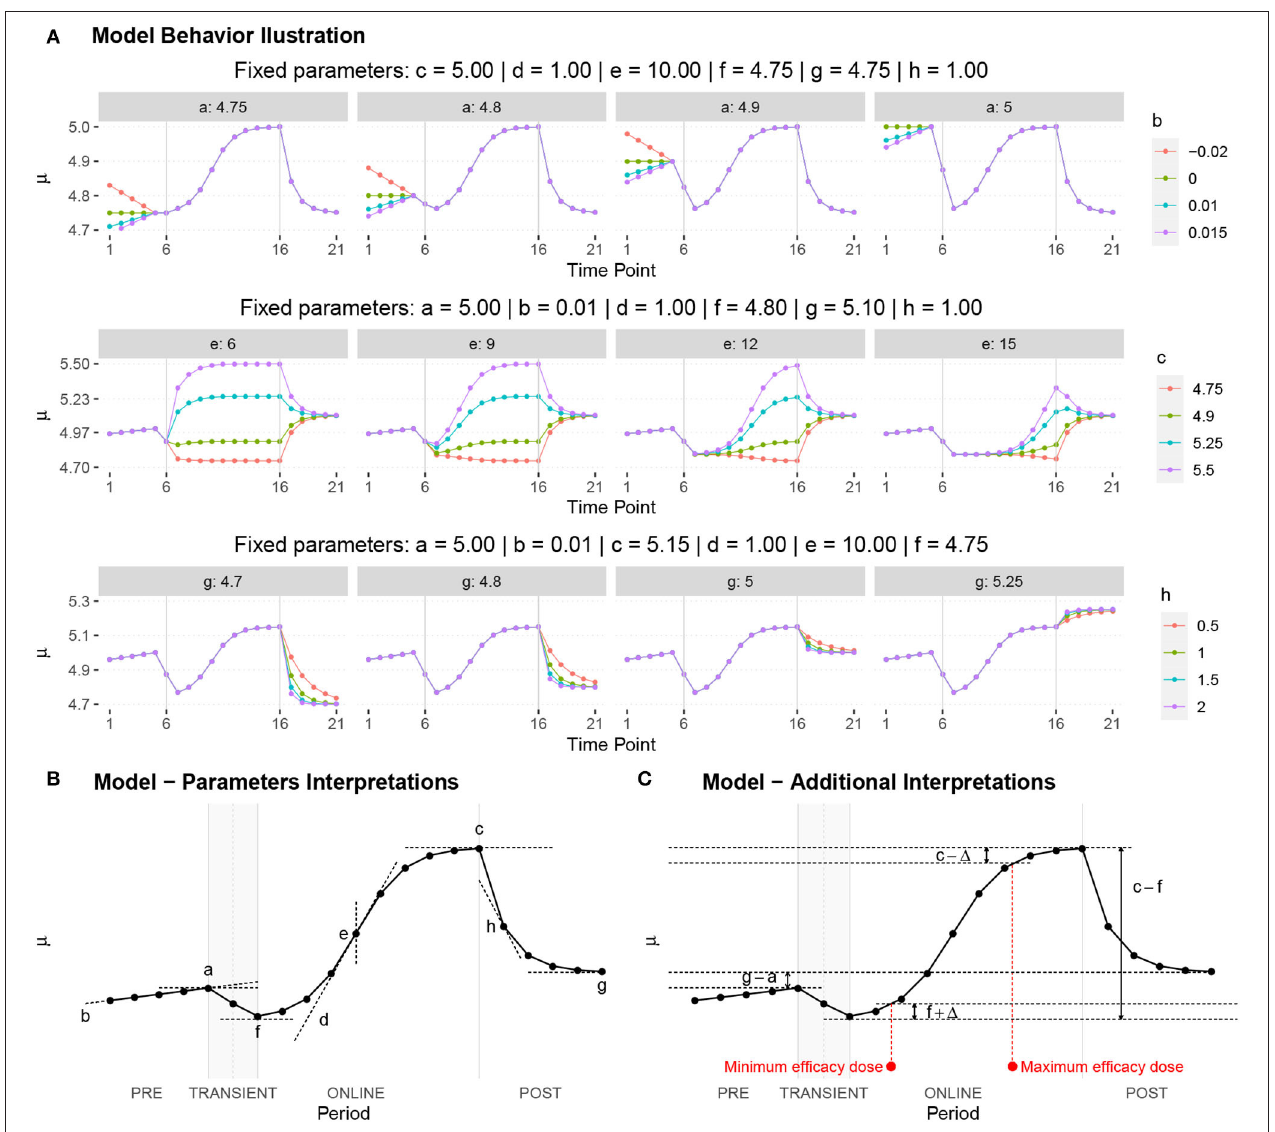
FIGURE 9 | (A) Illustration of the proposed model to represent the expected dynamics of the experiment. (B) The highly interpretative fundamental model parameters (the parameters { a , b , c , d , e , f , g , h } ) and some of its functions in (C) .